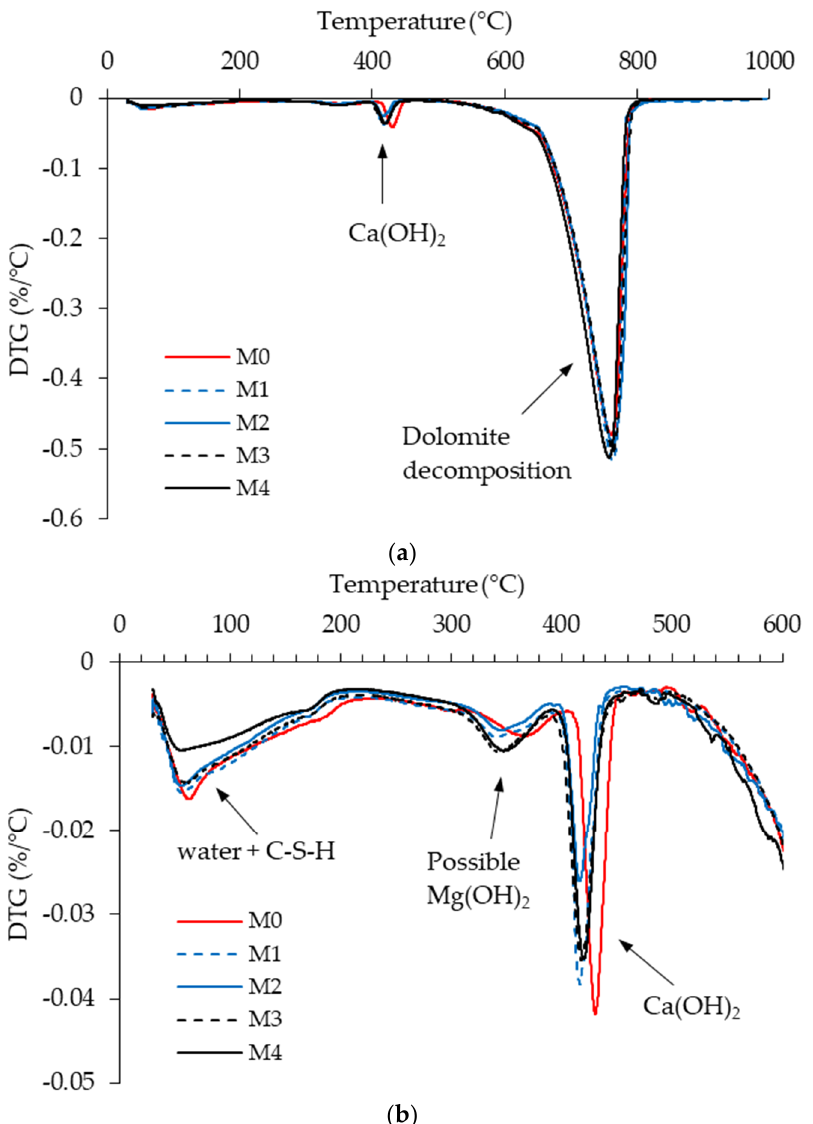
Figure 7. Results of the TG analysis. ( a ) DTG curves in the entire temperature range from 30 to 1000 °C; ( b ) enlarged DTG curves in the temperature range up to 600 °C.